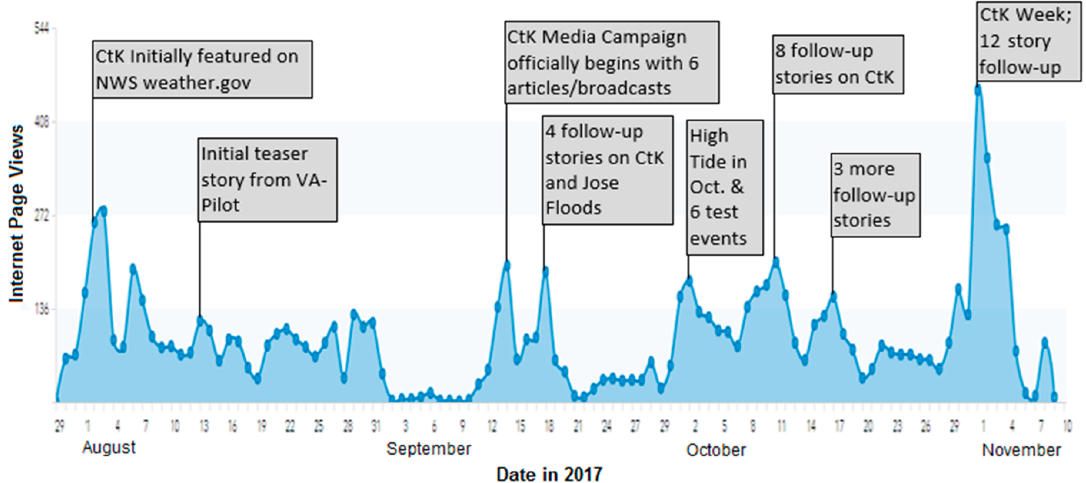
Figure 2. Catch the King (CtK) citizen engagement time series chart corresponding to major news